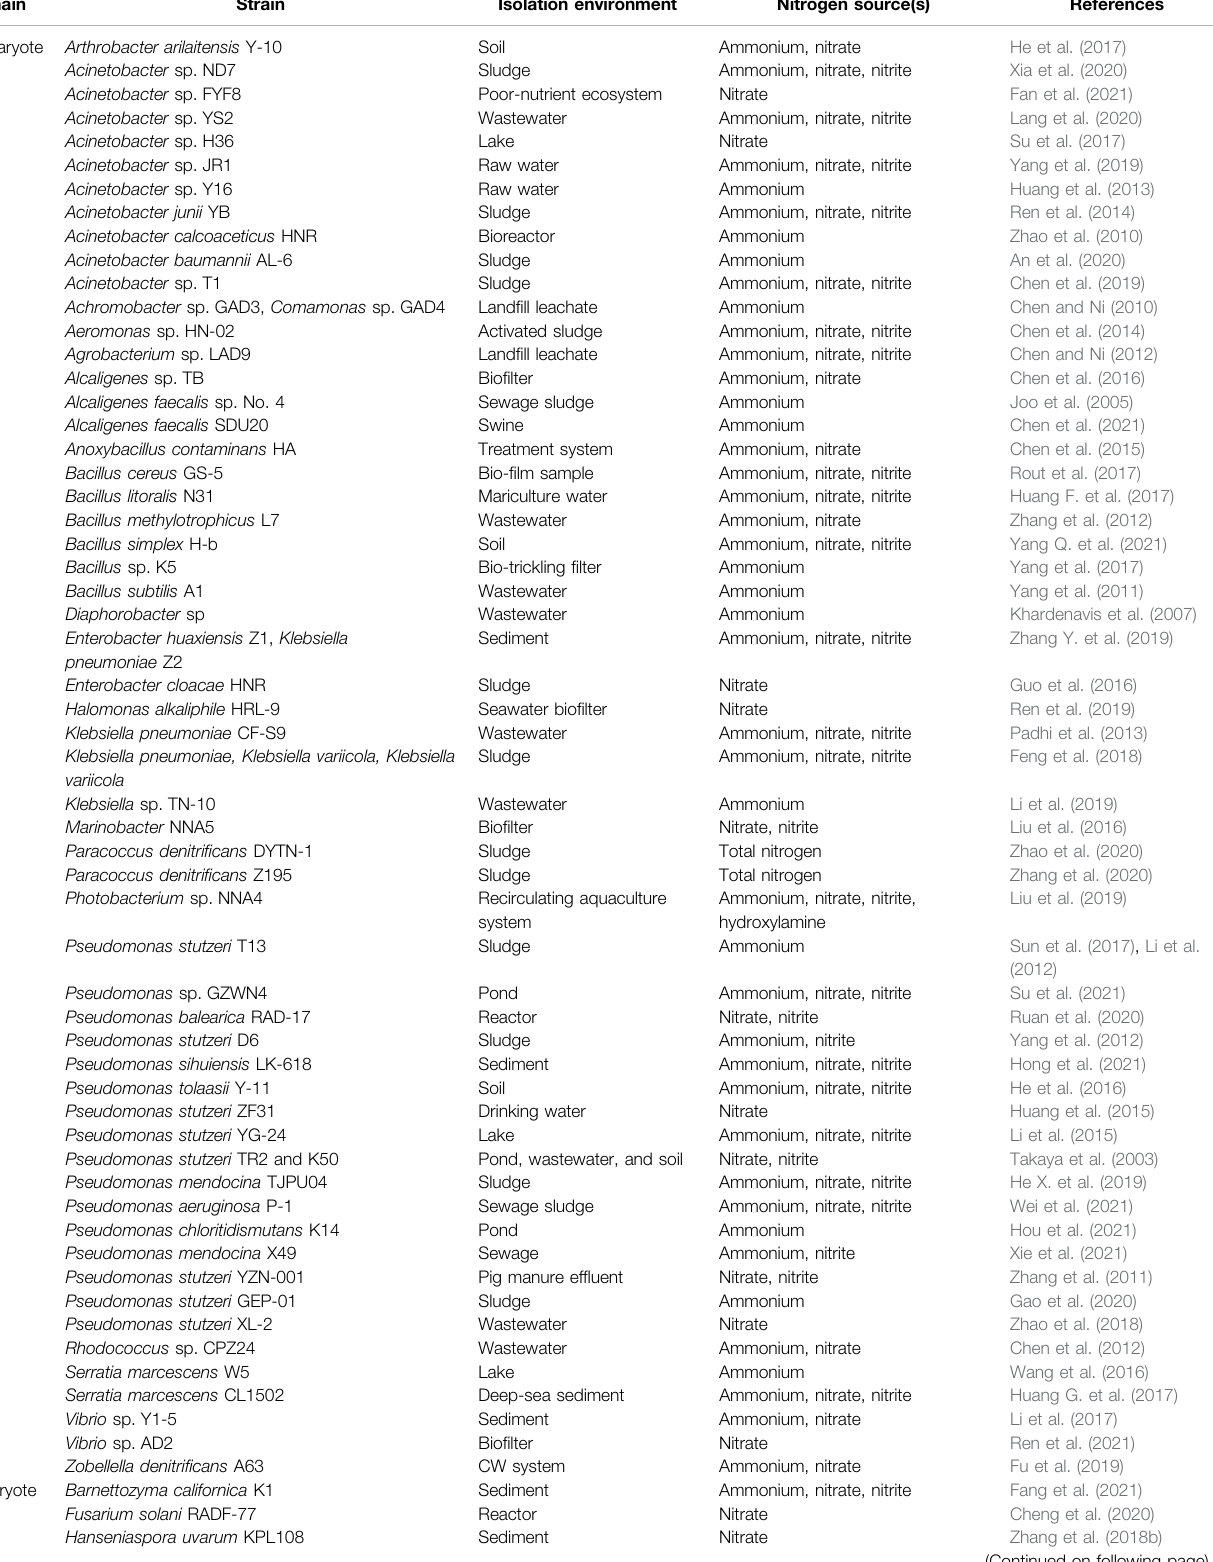
TABLE 1 | Distribution and domains of